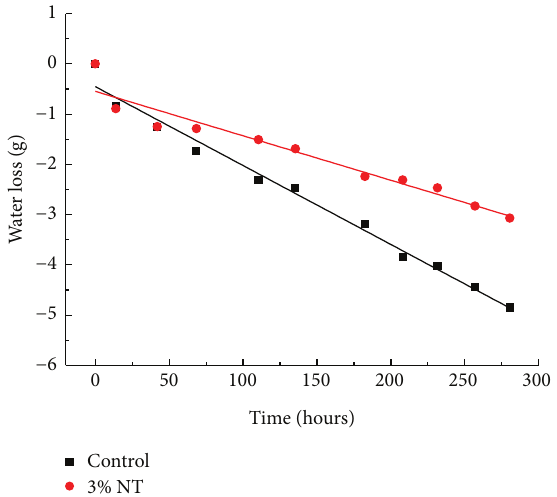
Figure 8: Water-vapour permeability of mortars before and after NT-modification ( 𝑤/𝑐 = 0.58).